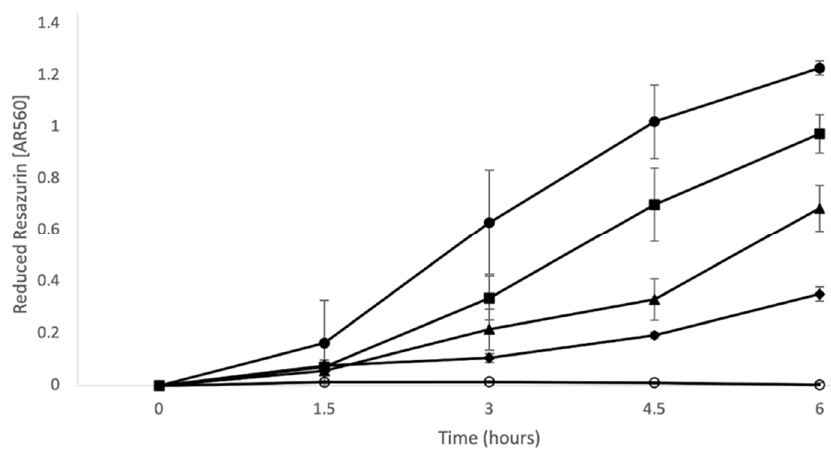
Figure 4. LL-37 and PMB individual versus combined treatment against P. aeruginosa PAO1 pre- grown biofilms. P. aeruginosa PAO1 biofilms were grown in a 96-well microtiter plate at 37 ◦ C for 24 h. Pre-grown biofilms were treated with 0.1 mM resazurin redox indicator and antimicrobial agents: LL-37 alone (16 µ g/mL; closed square), PMB alone (2 µ g/mL; closed circle), and PMB + LL-37 combination treatment (2 µ g/mL PMB + 16 µ g/mL LL-37 closed diamond). Water in the absence of P. aeruginosa PAO1 and antimicrobial agents (opened circle) was included as a control for the absorbance of non-reduced resazurin. Control wells containing P. aeruginosa PAO1 in the absence of antimicrobial agents were grown in MH media (closed triangle), as the antibiotic and peptide stock solution were prepared in this medium. Every 1.5 h, the amount of reduced resazurin (resorufin) was measured at 560 nm. The timepoints on the image show the mean average and standard deviation of two independent experiments, each performed in triplicate.